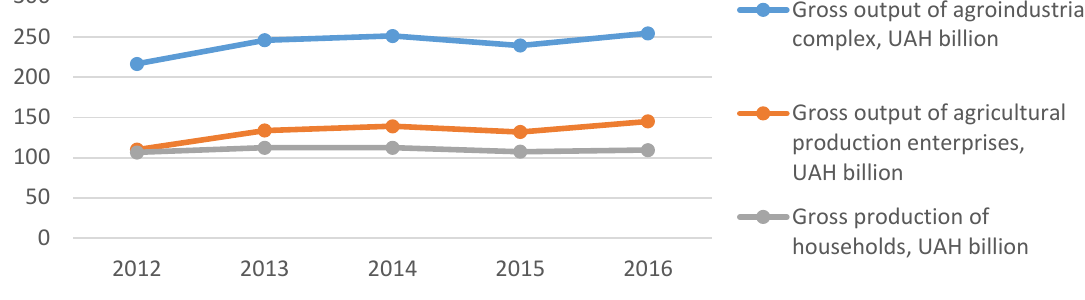
Figure 1. Volume of gross agricultural production